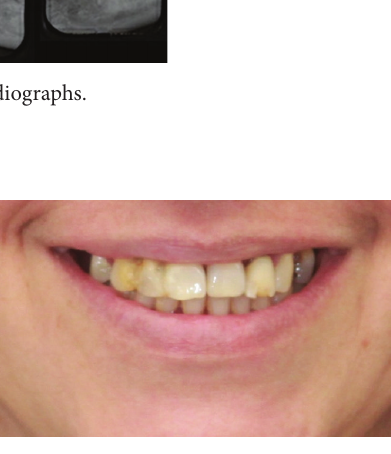
Figure 2: Pre-treatment smile